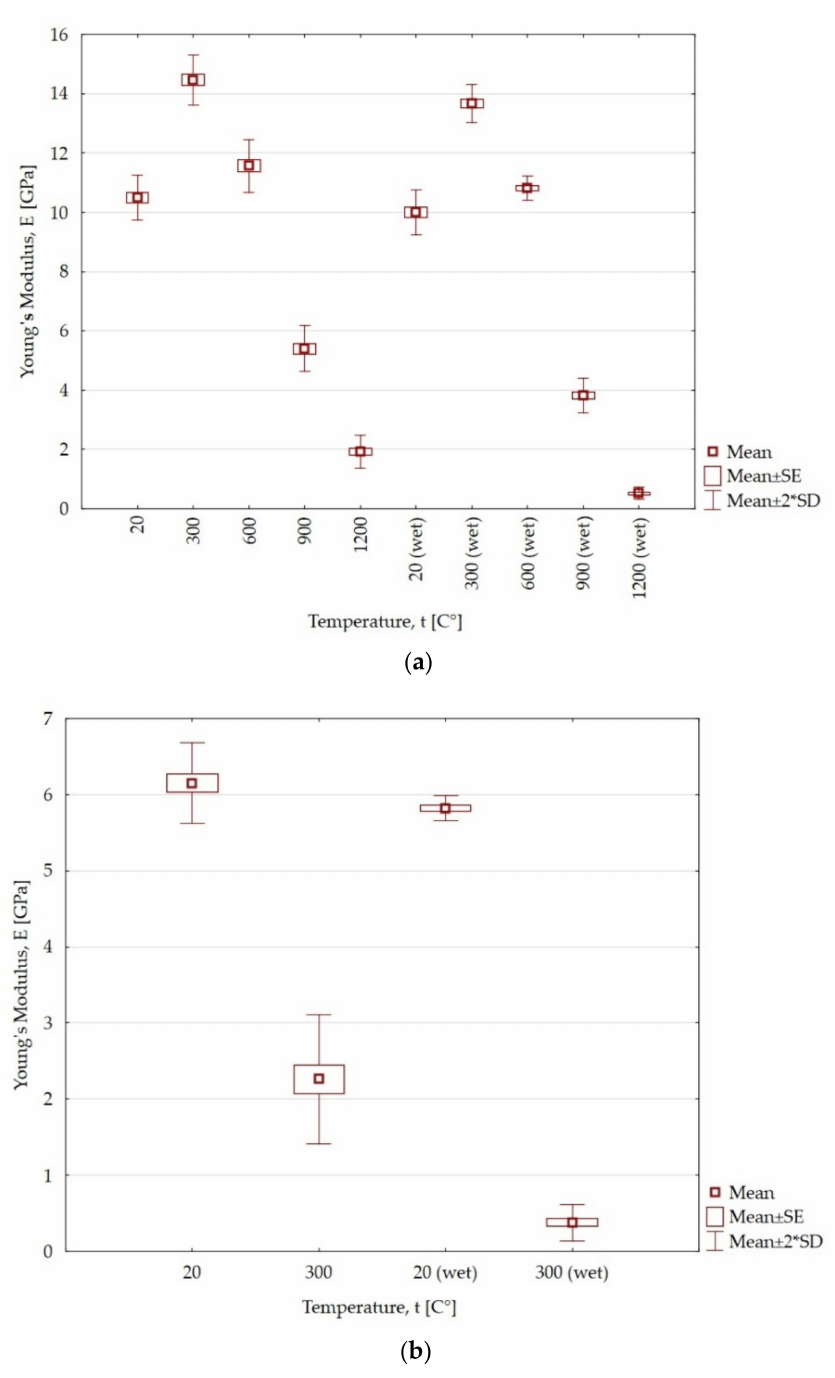
Figure 7. The influence of high temperatures on the changes in Young’s modulus: ( a ) sandstone; ( b ) claystone; SE—standard error; SD—standard